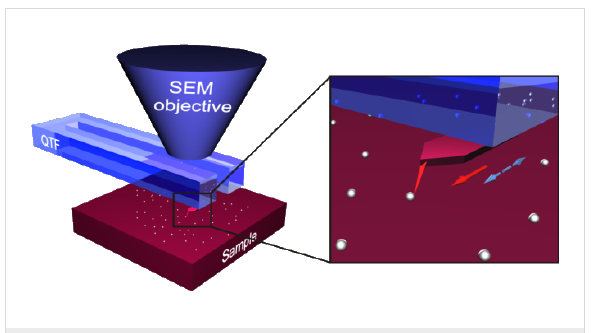
Figure 1: Schematics of the manipulation experiments inside an SEM. Solid arrow indicates the direction of the tip movement. Dashed arrow indicates QTF oscillation